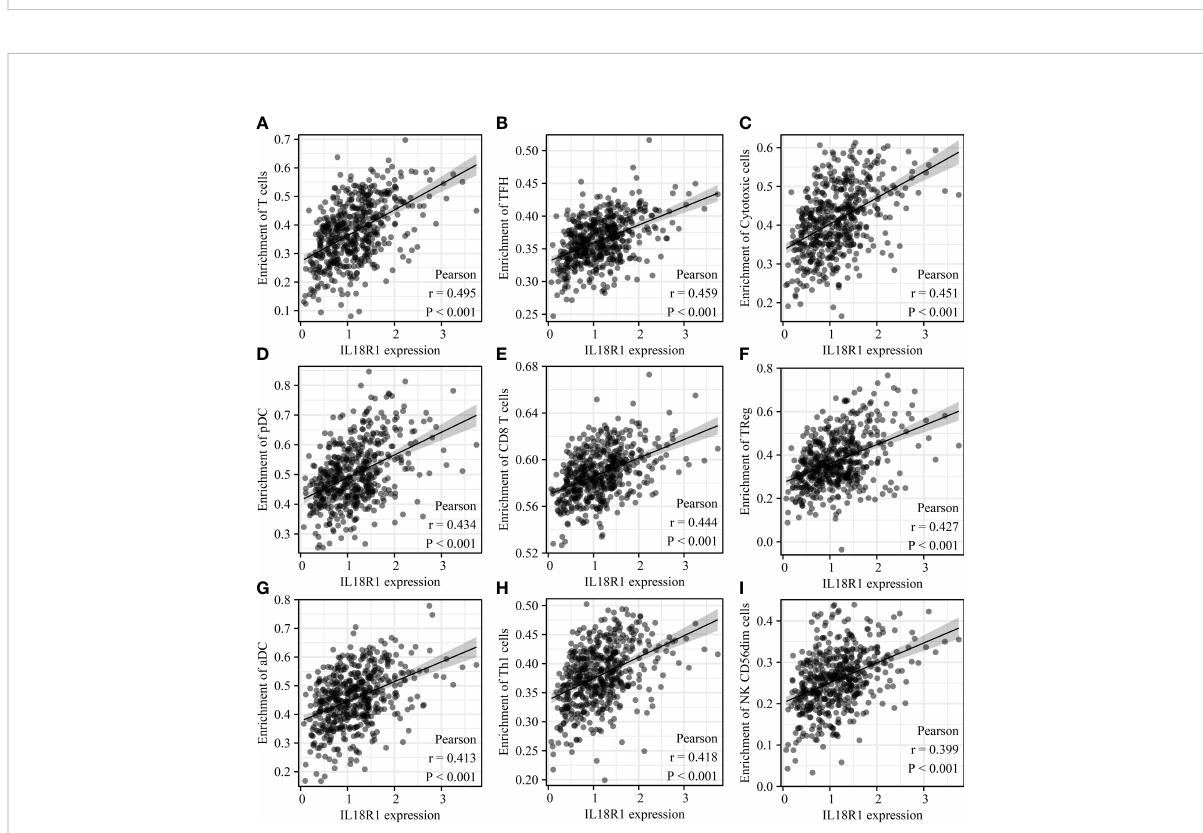
FIGURE 8 IL18R1 was signi fi cantly associated with the levels of immune cells in LUSC. (A) T cells; (B) TFH; (C) Cytotoxic cells; (D) pDC; (E) CD8 T cells; (F) TReg; (G) aDC; (H) Th1 cells; (I) NK CD56dim cells. LUSC, lung squamous cell